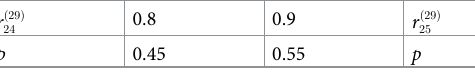
Table 3. Probability distributions of r ð 29 Þ r ð 29 Þ 24 0.8